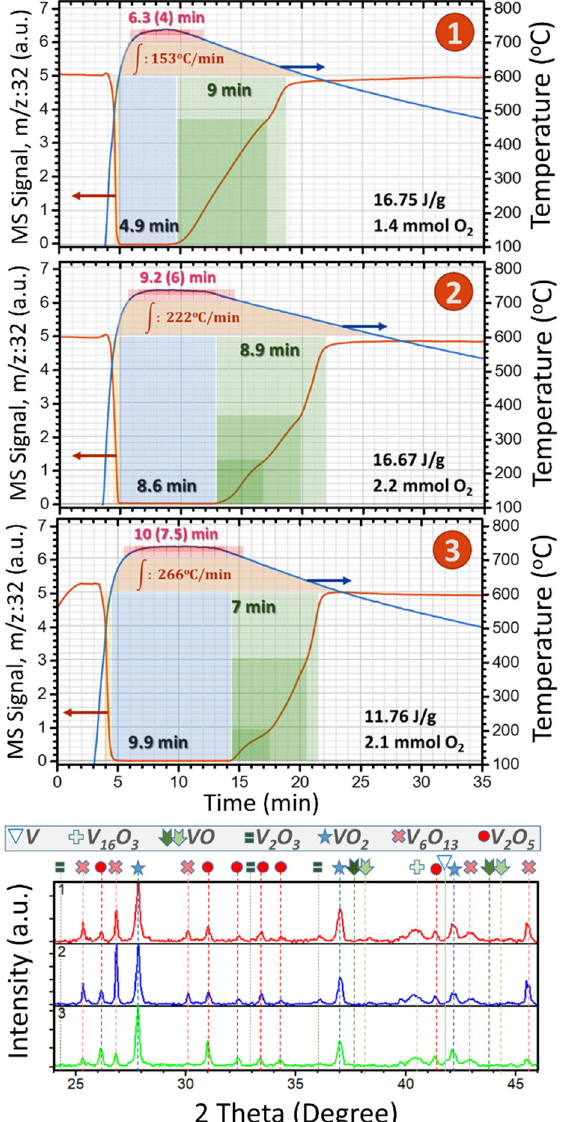
Figure 3. TPO-MS and XRD for V oxidized at 725 °C at different times, with ~10 °C s − 1 and ~0.05 °C s − 1 heating and cooling rates, respectively. The total spent of O 2 , and the DSC result for the products are labeled.